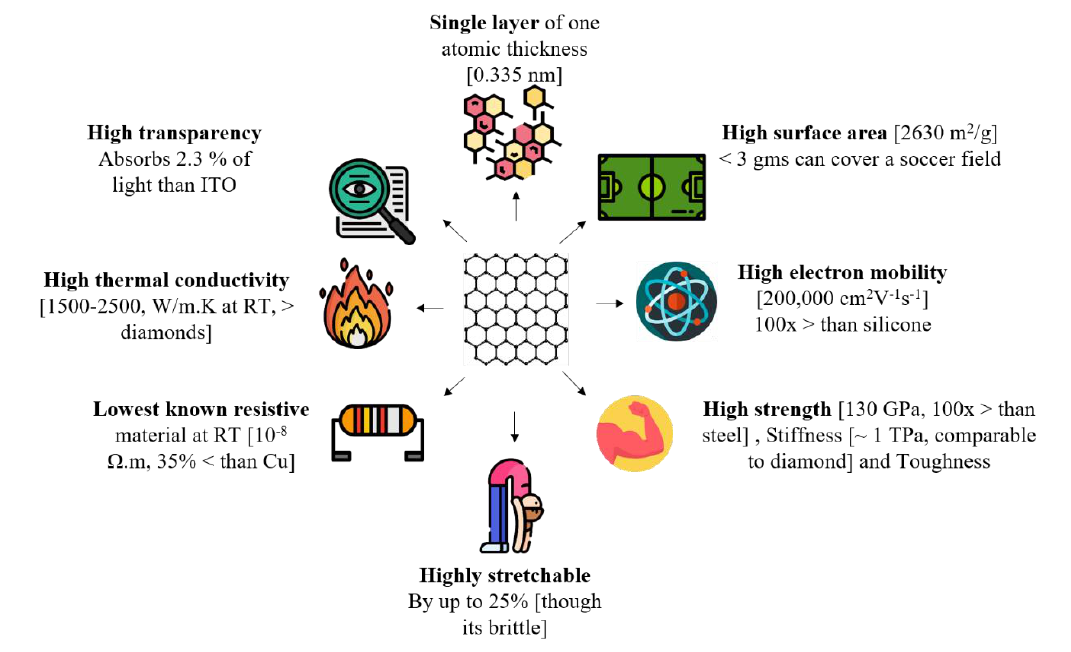
Figure 1. Schematic detailing the properties of pristine graphene.